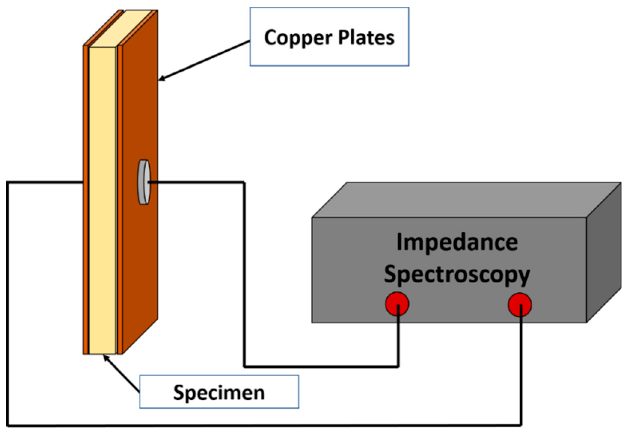
Figure 1. Experimental setup for the impedance spectroscopy measurements.